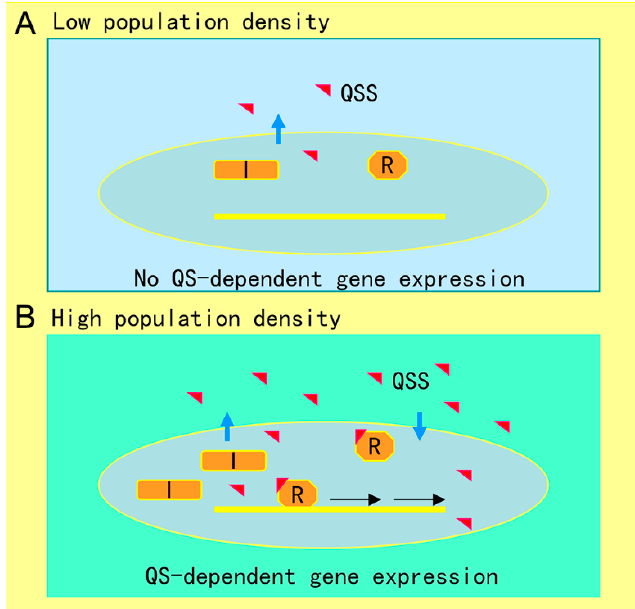
Figure 1. Illustration of quorum sensing (QS) mechanism in microorganisms. ( A ) At low cell population density, bacterial cells produce limited QS signal (QSS) which cannot trigger QS-dependent gene expression. ( B ) Along with bacterial growth, accumulated QSS interacts with and hence activates its cognate receptor to induce virulence factor production, biofilm formation, and generation of e ffl ux pumps, which aid the pathogen survival in the host by counteracting various possible stresses, including immune responses and antibiotics. Symbols: I represents the QS signal synthase, R is the receptor, and the red triangle indicates QS